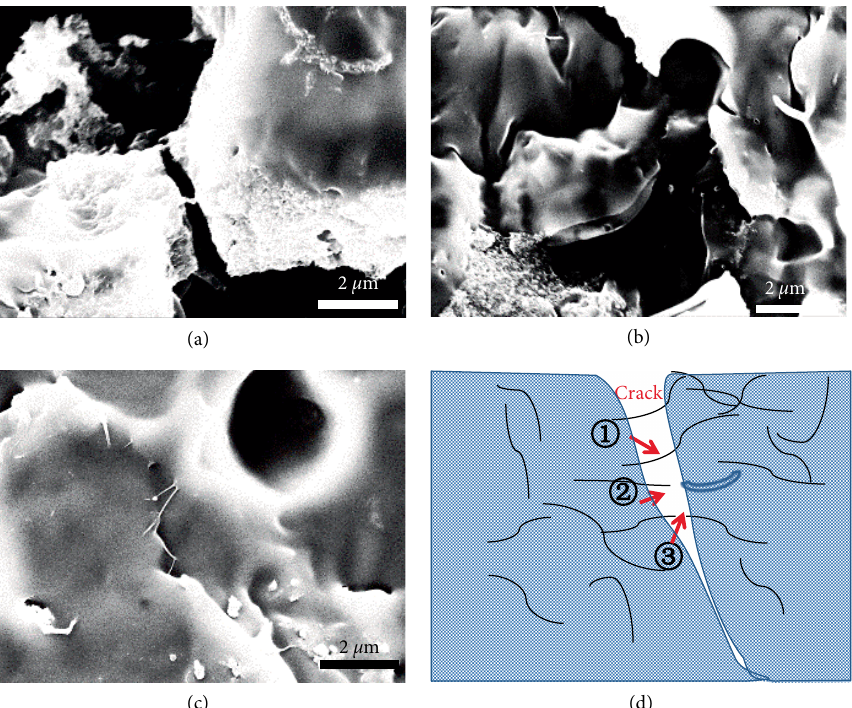
Figure 7: The introduced (a) bridging, (b) pulling out and (c) pinning effect of CNTs in PLLA scaffold. (d) Models of reinforcement mech- anisms.